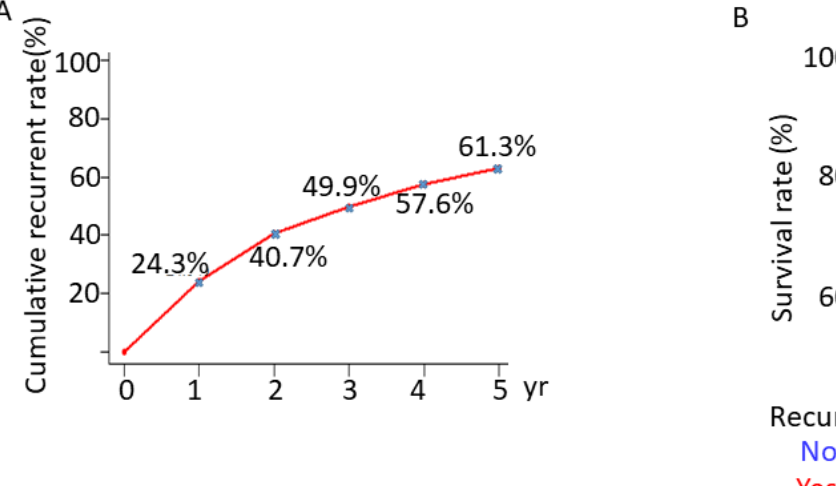
were 97.77% versus 97.75%, 87.63% versus 92.92%, and 73.63% versus 91.64% at 1, 3, and 5 years, respectively (Figure 2B).